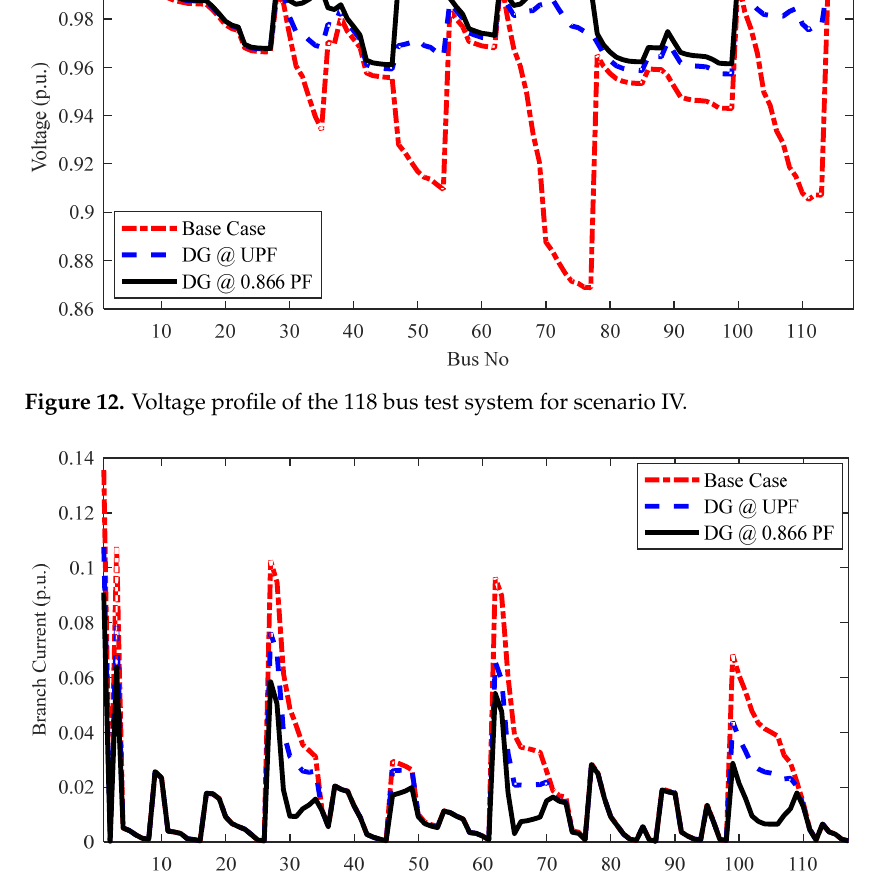
Figure 13. Branch current profile of the 118 bus test system for scenario IV.